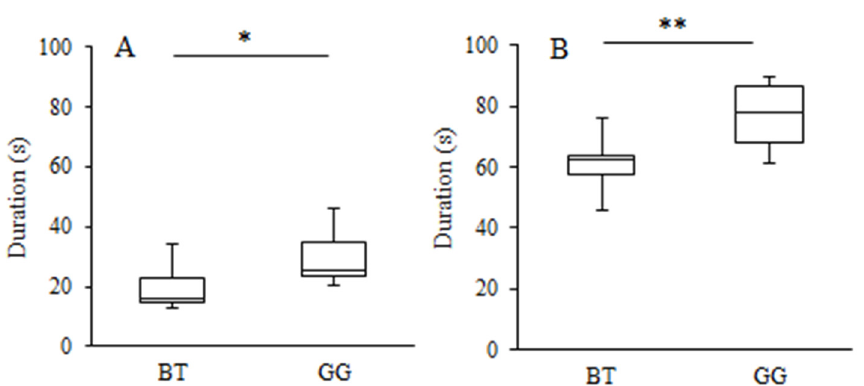
Figure 8. Box plots of exploration-related behaviours: ( A ) the two species’ ‘exploration after a change of pattern occurs, measured as the mean duration in seconds from opening the last well to leaving the box when the parrots first experience a change in the first week. ( B ) The mean time in seconds spent on the table across trials (BT = Blue-throated Macaws, GG = Great Green Macaws). * p < 0.05, ** p < 0.01.